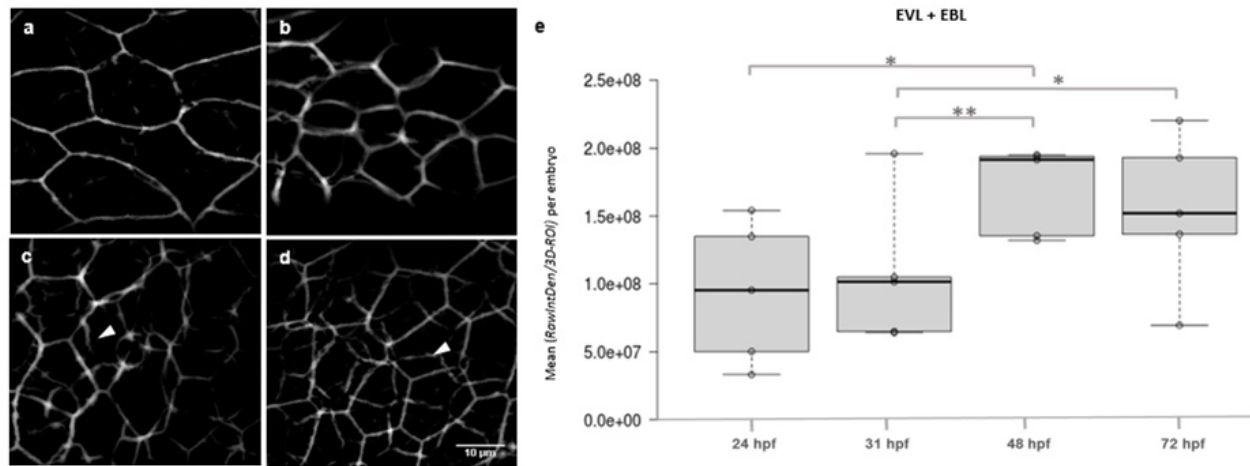
Figure 2. Expression patterns of E-cadherin (E-cadh) during epidermis development from stage 24-to-72 hours post fertilization (hpf). a ) 24 hpf and b ) 31 hpf, with incipient E-cadh labeling of the underlying epidermis basal layer (EBL) cells; c ) 48 hpf; d ) 72 hpf, with stronger detection of E-cadh in the EBL (arrow heads). Panels are representative 3D-ROIs classified images shown as sum of intensities in projections of 20-optical section stacks covering the epidermis thickness (6.6 µm); e ) Box-plot of means of RawIntDen/ROI per embryo.